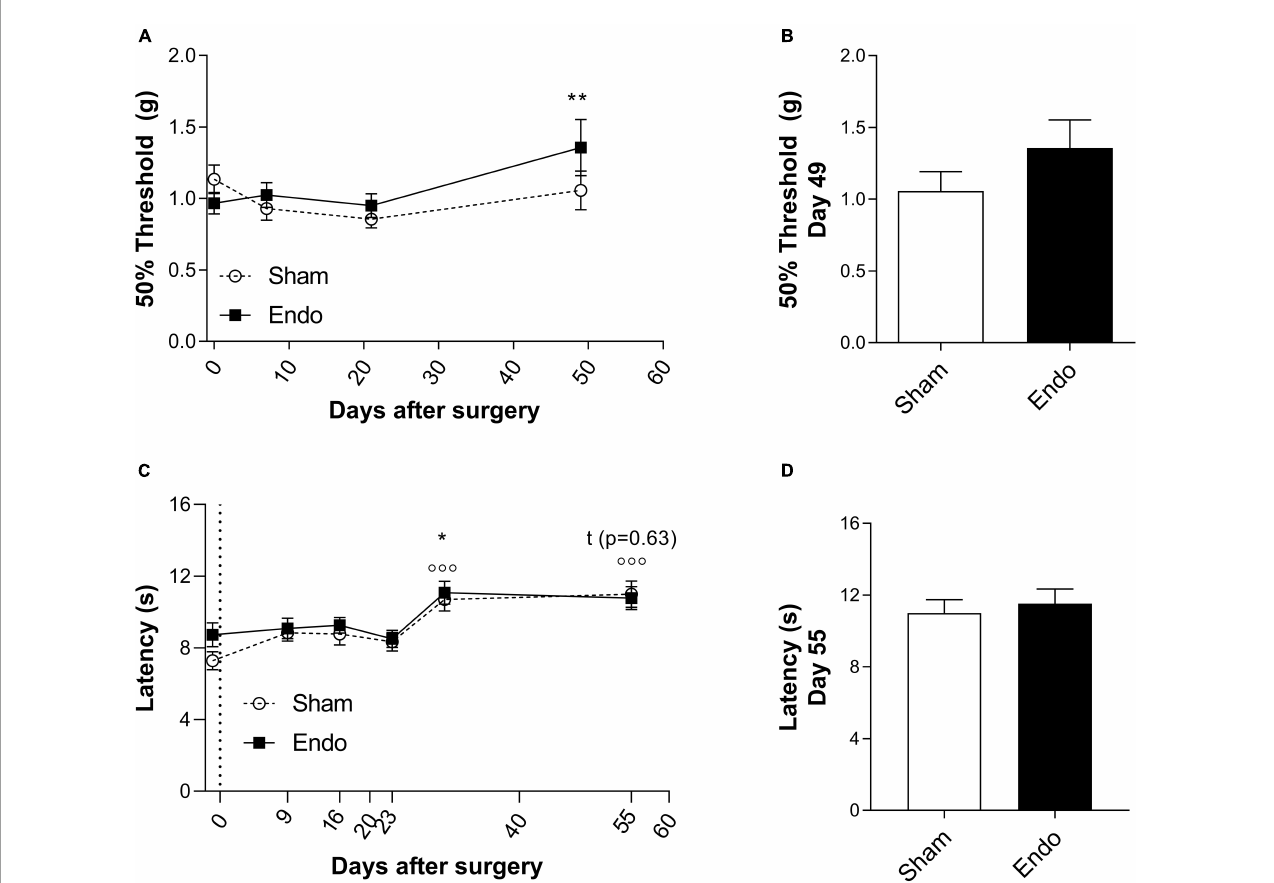
FIGURE2 Pain-related behavior in endometriosis-induced mice. MPT (A,B) and TPT (C,D) measured by the von Frey and the Hargreaves test in sham ( n = 23) and EIM ( n = 24). (A) Time course of the MPT (expressed in means of 50% force to react to the mechanical probe) of sham and EIM along 49 days, at days 0 (baseline), 7, 21, and 49 after surgery. (B) MPT between EIM and sham mice at day 49 after surgery. (C) Time course of the TPT (expressed in means of time to react to the heat stimulus) of sham and EIM along 55 days, measured on days: − 1, 9, 16, 23, 30, and 55 after surgery. (D) TPT between EIM and sham mice at day 55 after surgery, no significant differences are observed. Data shown as mean ± SEM. * = p <